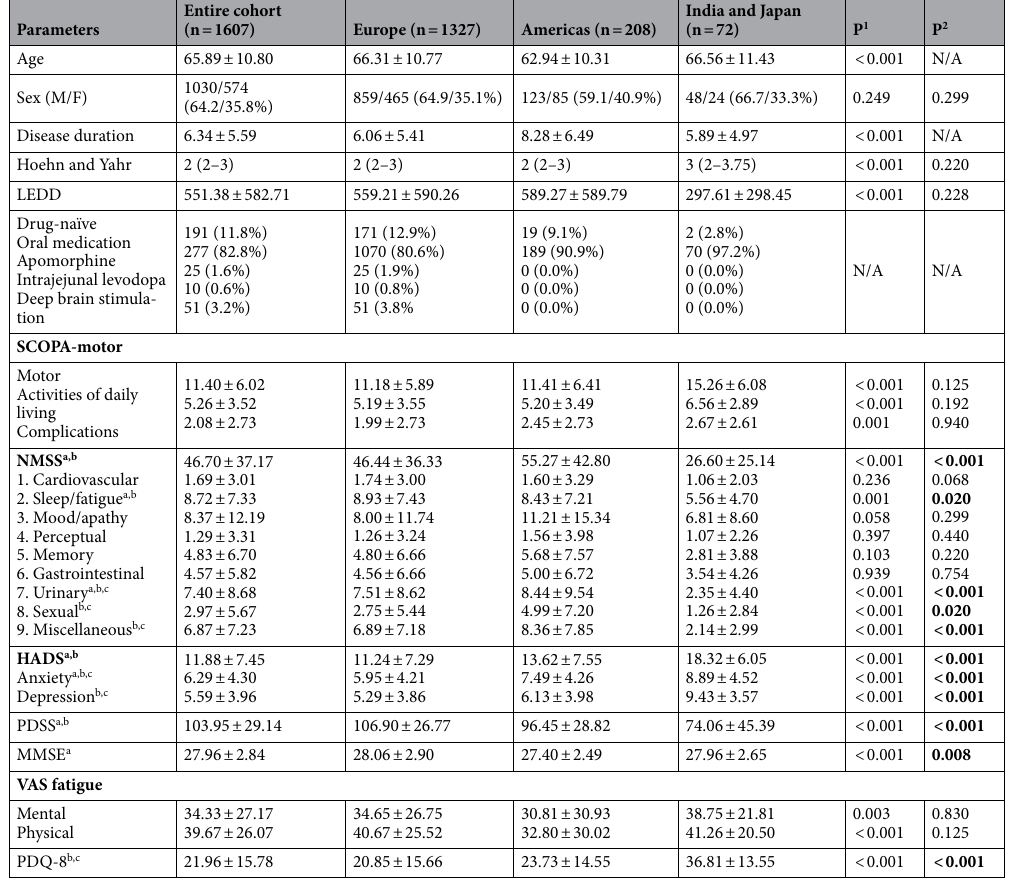
Table 1. Demographic data for the entire cohort and across different geographical sites of assessment. Data presented as mean ± standard deviation, except for Hoehn and Yahr stage (median (25th-75th percentile)), or number (percentage). 1—uncorrected p-value; 2—p-value after Quade’s rank analysis correcting for age and disease duration and after correction for multiple testing using a Benjamini Hochberg procedure. Post-hoc analyses (corrected values using Benjamini–Hochberg procedure): a difference between Europe and Americas (p < 0.05); b difference between Europe and India/Japan (p < 0.05); c difference between Americas and India/ Japan (p < 0.05). P-values in bold are significant (p ≤